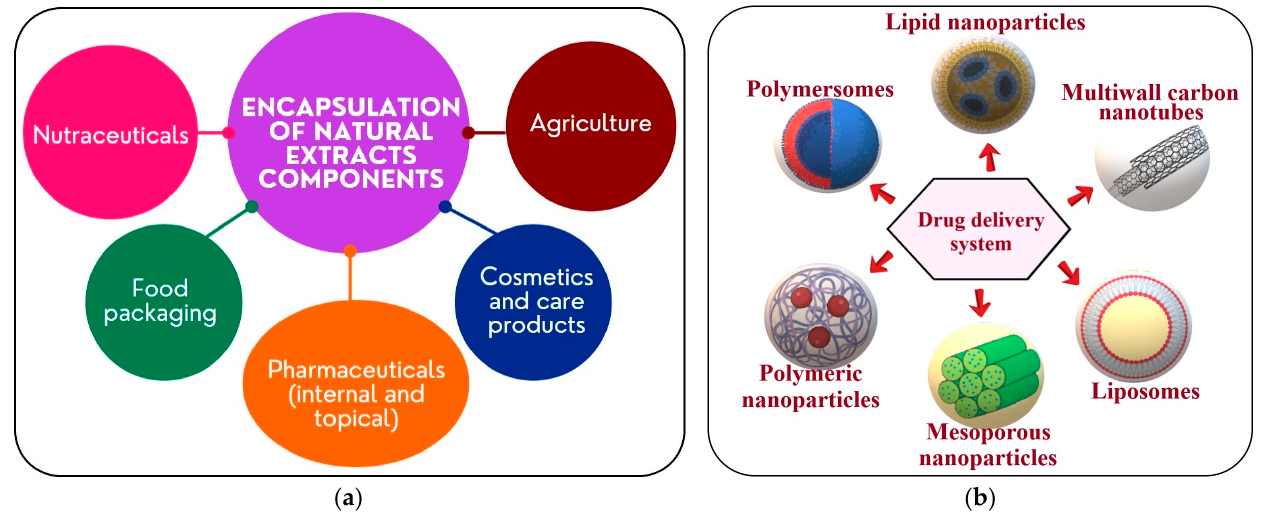
Figure 6. The encapsulation of natural extracts and their applications ( a ); Drug delivery systems for bioactive substances ( b ).